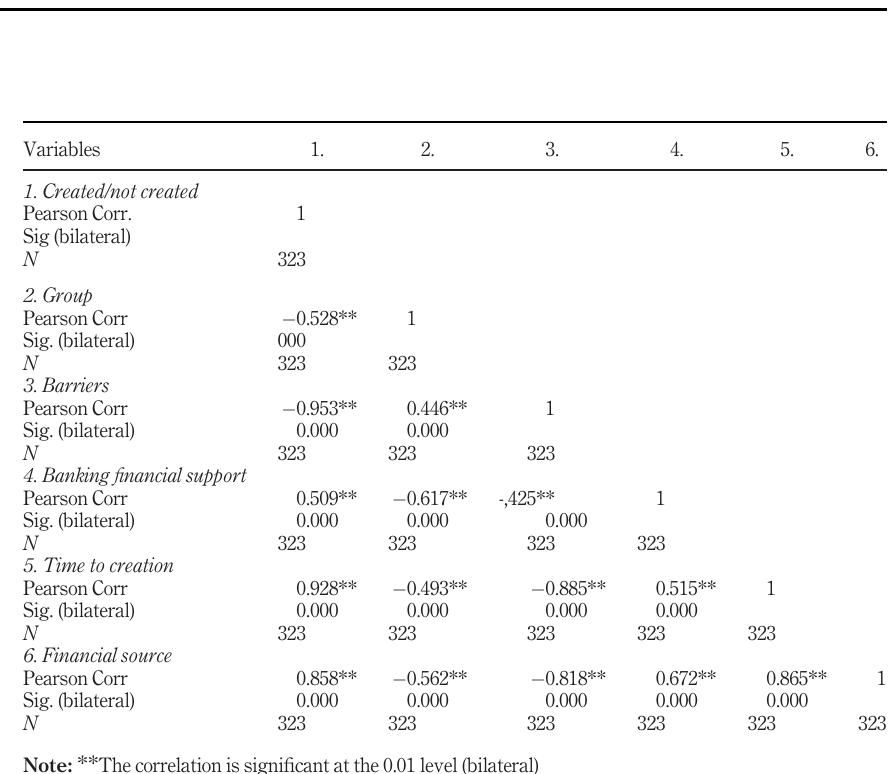
Table III. Correlation matrix